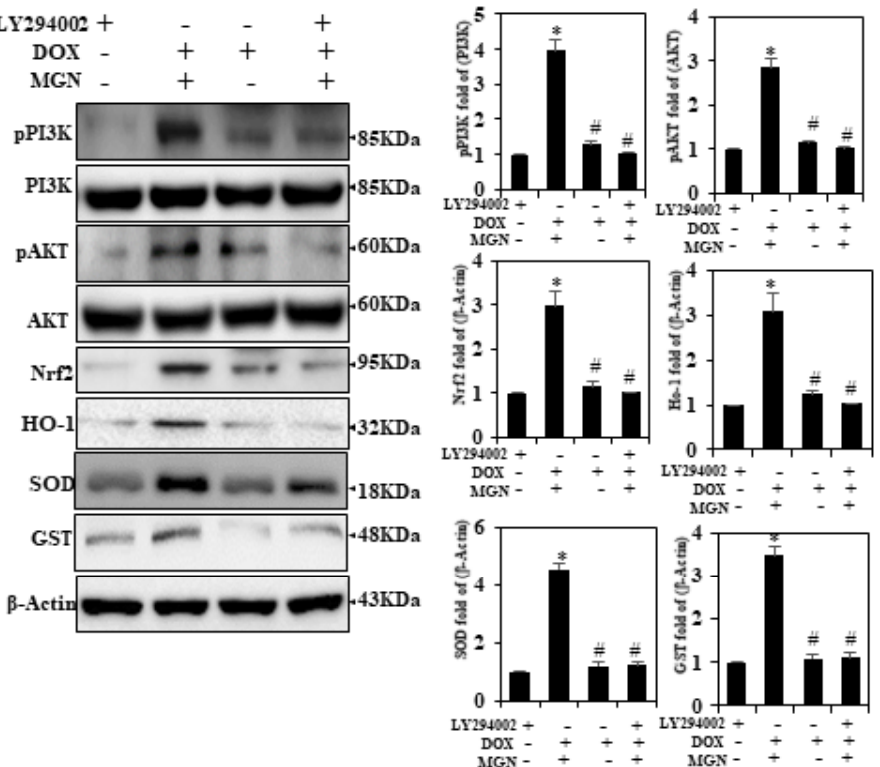
Figure 4. MGN-mediated Nrf2 activation by PI3K/AKT signaling pathways in HUVECs. Cells were pretreated with PI3K/AKT inhibitor LY294002 (30 µ M) for 30 min, followed by MGN (20 µ M) and/or DOX (1 µ M) for 24 h. Western blot was performed to detect the pPI3K, pAkt, HO-1, Nrf2, SOD, and GST levels by anti-pPI3K, anti-pAkt, anti-HO-1, anti-Nrf2, anti-SOD, and anti-GST. The outcome was measured and expressed as a fold change compared to the control (n = 3). Data were analyzed by one-way ANOVA, and Tukey’s post hoc experiments were used to analyze the similarities between groups. * p < 0.05 reflects significant differences from the healthy control. # p < 0.05 reflects significant differences in contrast to DOX alone and MGN with DOX-treated groups.